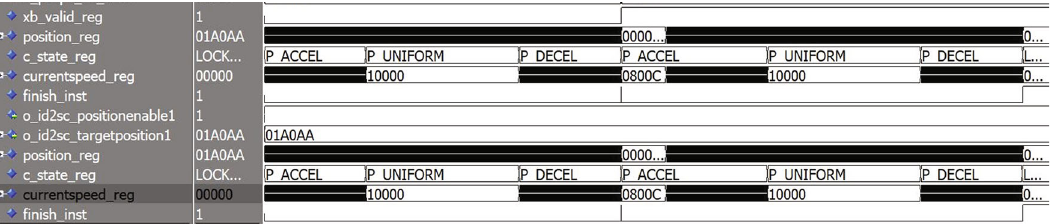
Figure 11: Simulation waveform of go to zero-position during 60 ° angle regulation.